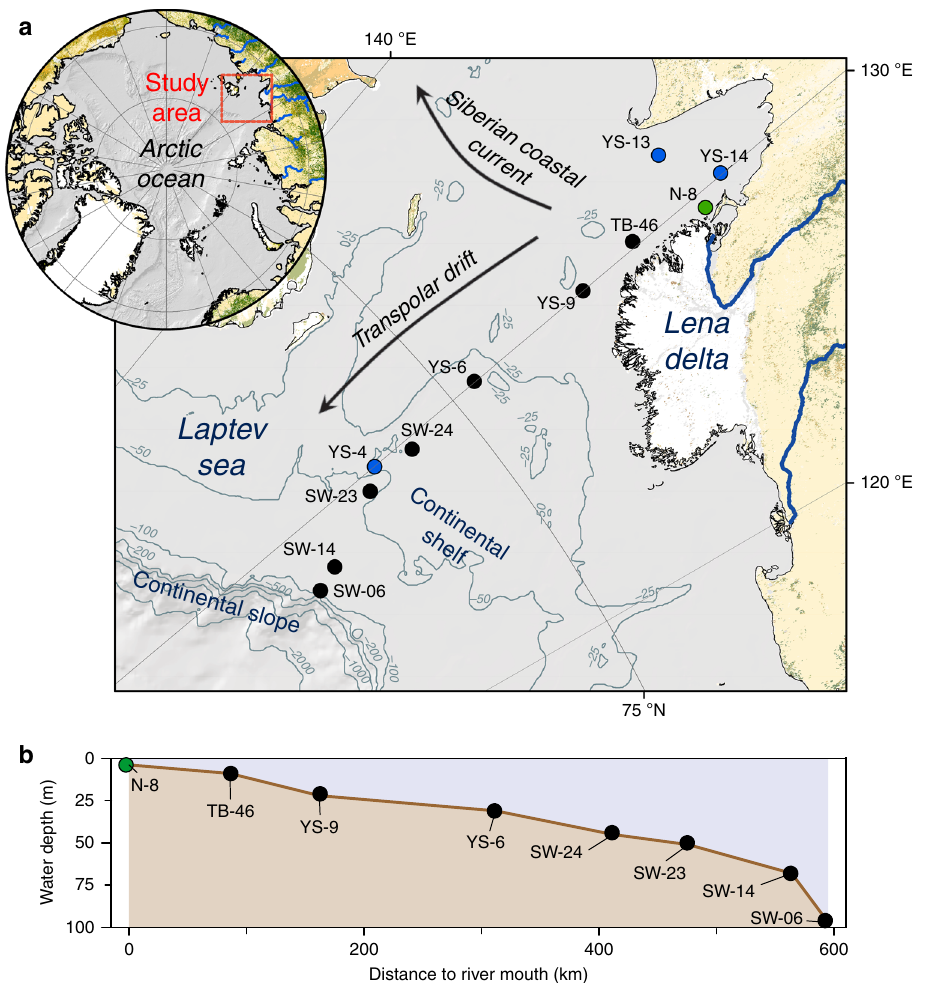
Fig. 1 Map of the study area and depth-distance relationship of the sampling stations along the transect. Filled black circles refer to sampling locations on which radiocarbon dating of uniquely terrestrial molecules (biomarkers) was performed for this study; fi lled green circle: sampling station for radiocarbon data from a previous study 16 , fi lled blue circles: sampling stations for additional biomarker data from an earlier study 19 . The underlying map was made with ArcGIS 10 using the latest version of the bathymetric grid IBCAO 3.0 59 . Arrows in ( a ) indicate net directions of the prevailing ocean currents. b The relationship between the distance from the river mouth (set as station